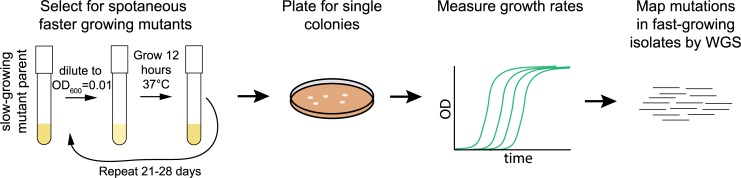
Experimental approach to isolate and map rescue (sup) strains.Strains harboring one of five deletions (Δzwf, ΔdapF, Δdgk, ΔentC, or Δppk) were suspended in M9 supplemented with 0.4% (w/v) of glucose (M9G) in triplicate. The deletion strains were allowed to grow at 37° C with shaking for 12 hours, at which point they were diluted to OD600 = 0.01. Adaptive evolution proceeded in this manner for 21–28 days (216–611 generations). At the end of this AE period, the culture was plated, colonies were recovered and resuspended in liquid media, and log-phase growth rates were measured, identifying sup strains. The genetic lesions associated with rescued growth were identified by whole genome sequencing (WGS).